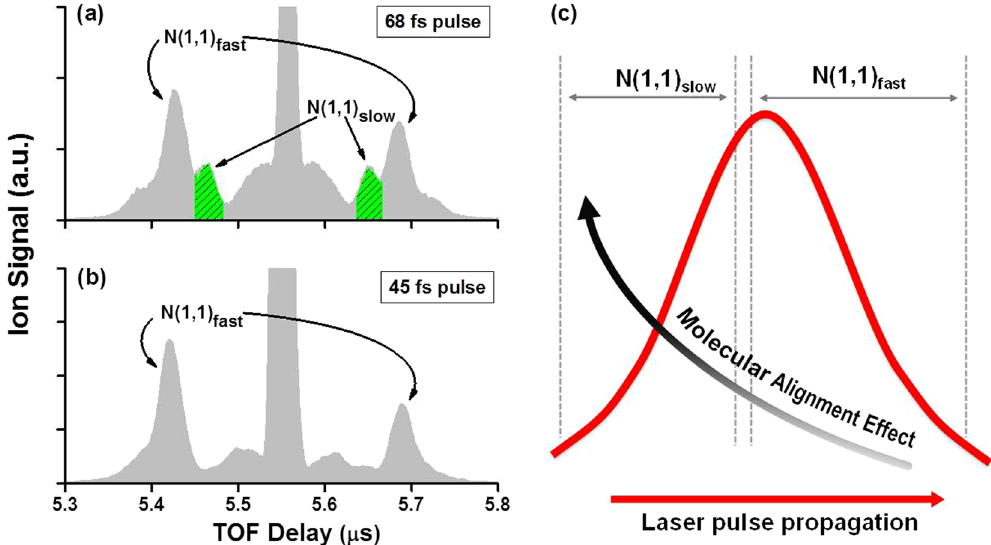
Figure 1. TOF spectra for the N(1,1) fast and N(1,1) slow channels from ionization and dissociation of N 2 using linearly polarized ( a ) 68-fs and ( b ) 45-fs pulses. N(1,1) slow is clearly seen in 68-fs pulses but nearly disappears in 45-fs pulses. ( c ) Schematic illustration of the formation time sequence of N(1,1) fast and N(1,1) slow